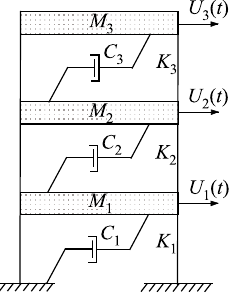
Fig. 1. Deformed column exposed to bending (as the result of horizontal earthquake loading) and simultane- ously to vertical load acting on its top.